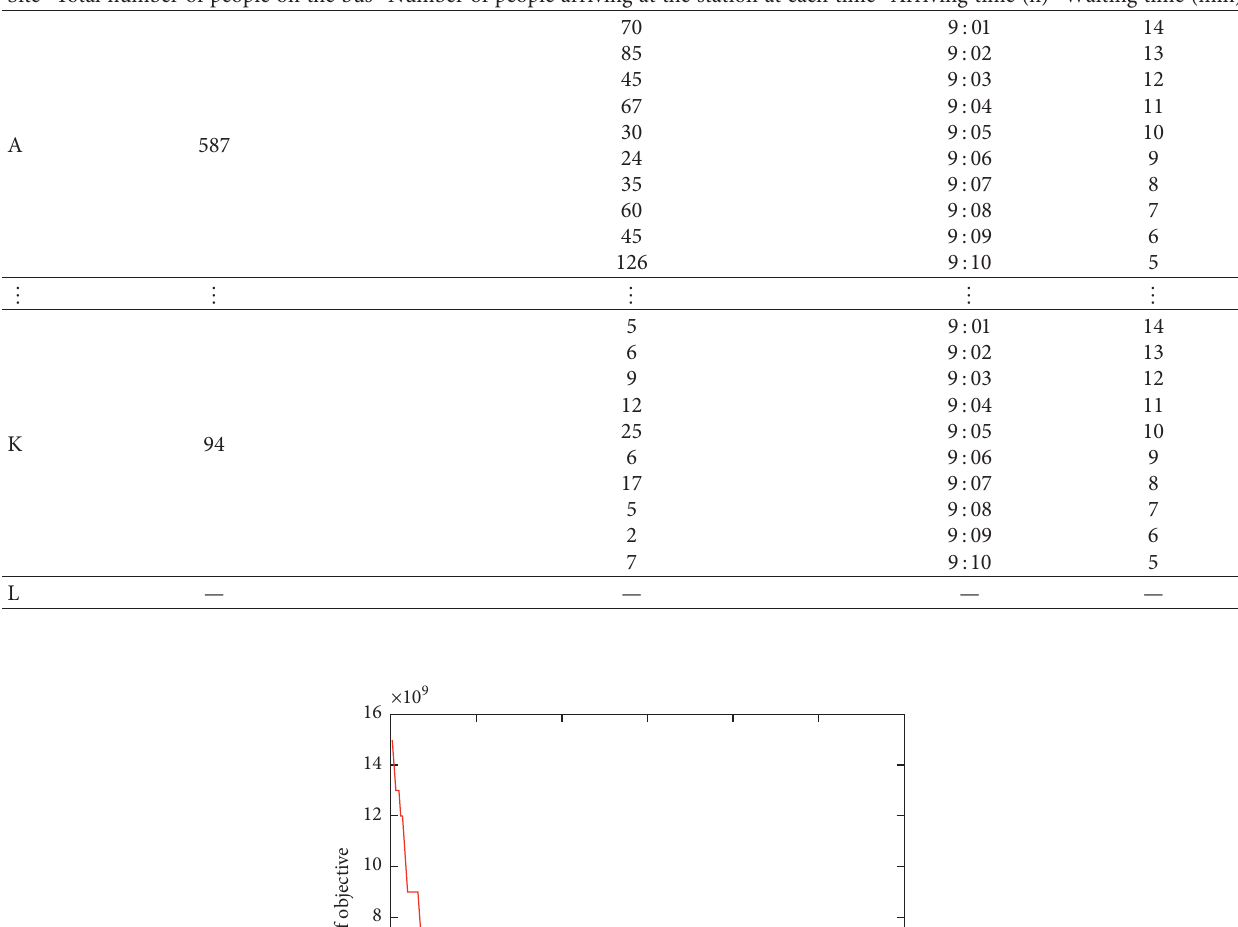
Table 7: Passenger waiting information statistics table at the last time node of each station.